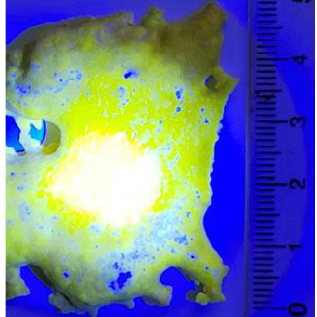
Figure 6. Photo of YAG:Ce ceramic sample synthesized at E = 1.4 MeV, P = 25 kW/cm 2 , illuminated by chip radiation λ = 450 nm.